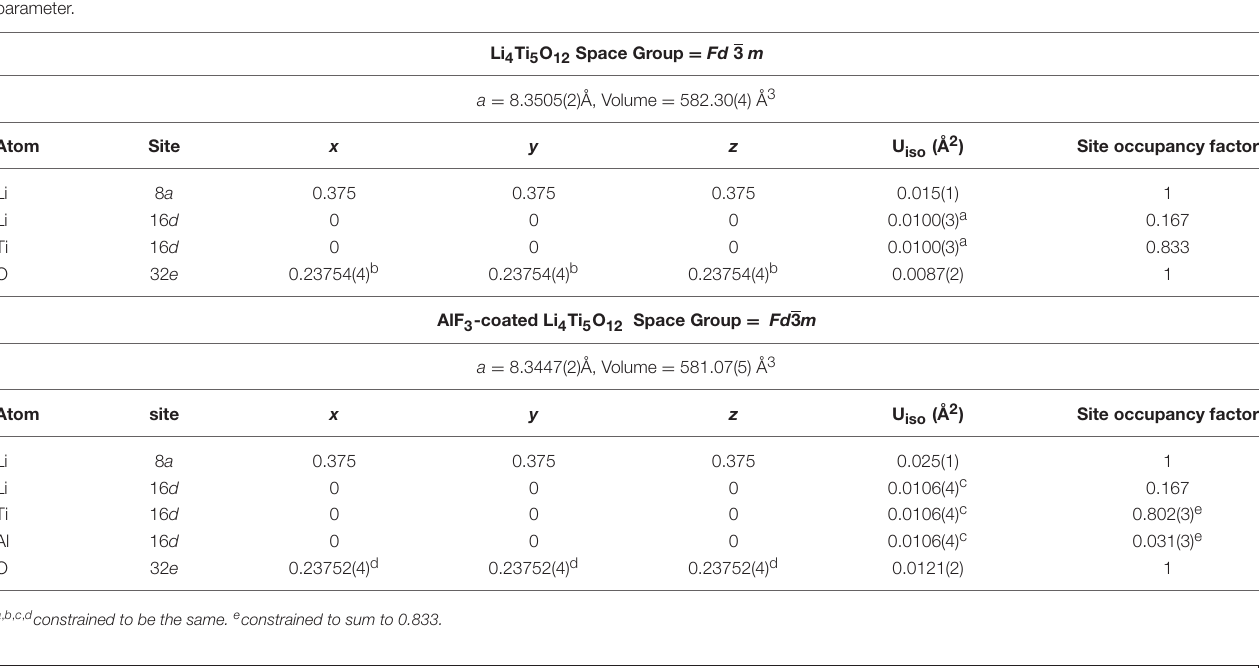
TABLE 1 | Crystallographic details of LTO and AlF 3 -coated LTO obtained from joint Rietveld analysis using XRPD and NPD data. U iso is the isotropic atomic displacement parameter.